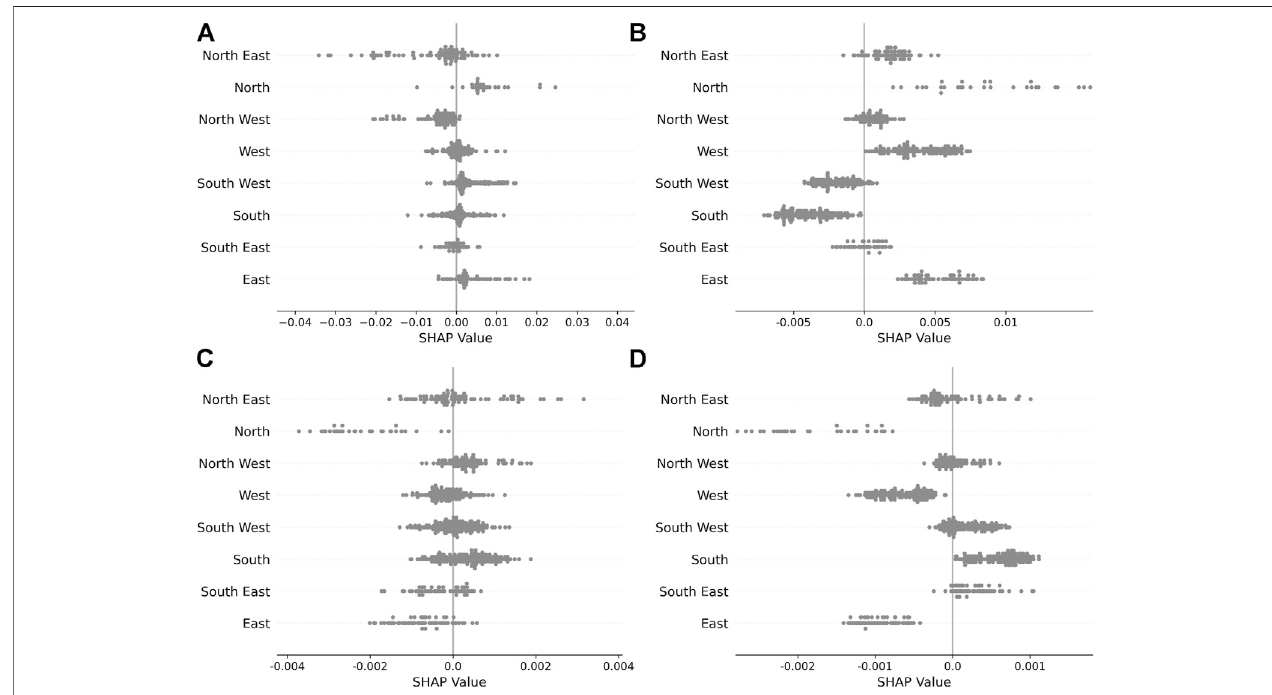
FIGURE 7 | SHAP values for the location feature. In each plot, we have summed the SHAP values for each one-hot encoded value, and then only plotted the resulting value in the row corresponding to each data-points true feature value. This shows the overall impact of the location feature, and allows one to view this impact separately for each value it attains. (A) : h (cid:2) 5. (B) : h (cid:2) 30. (C) : h (cid:2) 60. (D) : h (cid:2)